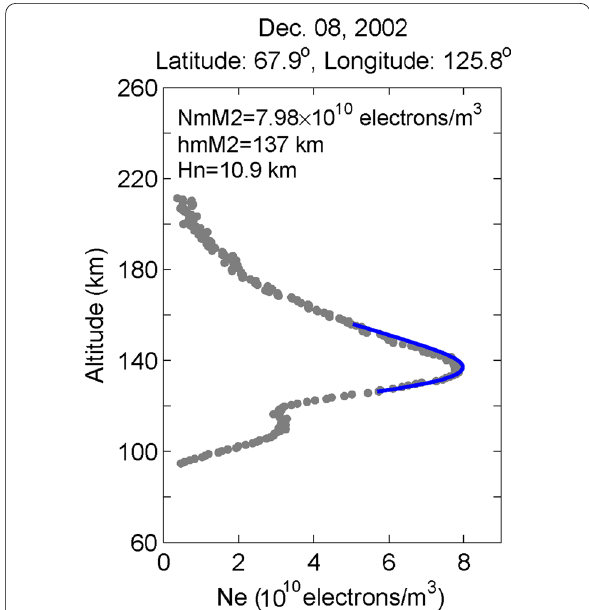
Fig. 1 A MGS electron density profile as an example illustrating Chapman-α fitting. The gray dots are MGS electron density measurements; the blue solid line is the Chapman-α fitting for the height range of – 10 km to 20 km around the M 2 peak. The fitting parameters are labeled, including N m M 2 , h m M 2 , and H